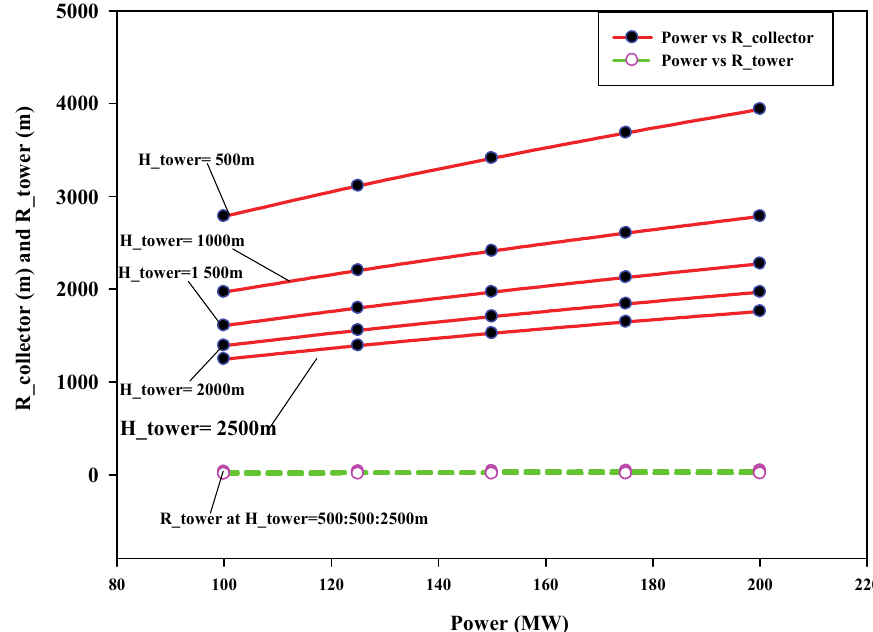
Figure 19. Effect of variation in power output on tower radius ( R Tower ) and collector radius ( R Collector ) for different tower height ( H Tower ) in SUTPP.